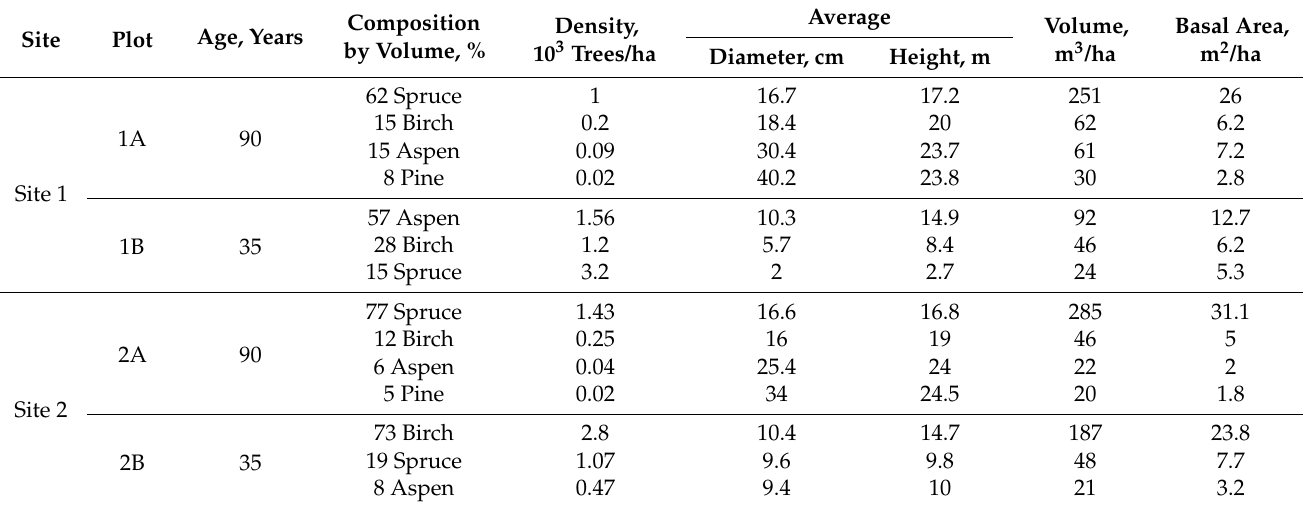
Table 1. Inventory characteristics of tree stands in the sampling plots.